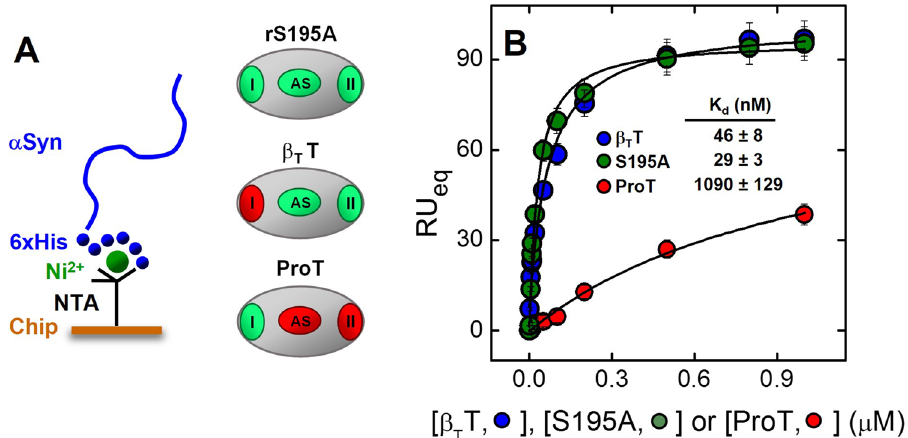
Figure 9. Effect of selective perturbation of thrombin exosites on the affinity for αSyn. ( A ) Schematic representation of the protease-domain of S195A thrombin mutant, β T -thrombin (β T T), and prothrombin (ProT). The active site (AS) and exosite 1 (I) and exosite 2 (II) are colored according to the conformational/ functional state they assume in the different thrombin derivatives, compared to αT (see text); green : unperturbed or only slightly perturbed; red : heavily perturbed. ( B ) SPR analysis of the binding of S195A, β T T, and ProT to 6xHis-αSyn immobilized on a Ni 2+ -NTA sensor chip. The values of RU max were plotted versus the concentration of thrombin derivatives and the data points were interpolated with Eq. 8 (Supplementary Material), yielding the corresponding K d values as indicated. Measurements were carried out at 37 °C in HBS-EP + , pH 7.4. The data points are the average of three independent measurements, with errors as ±